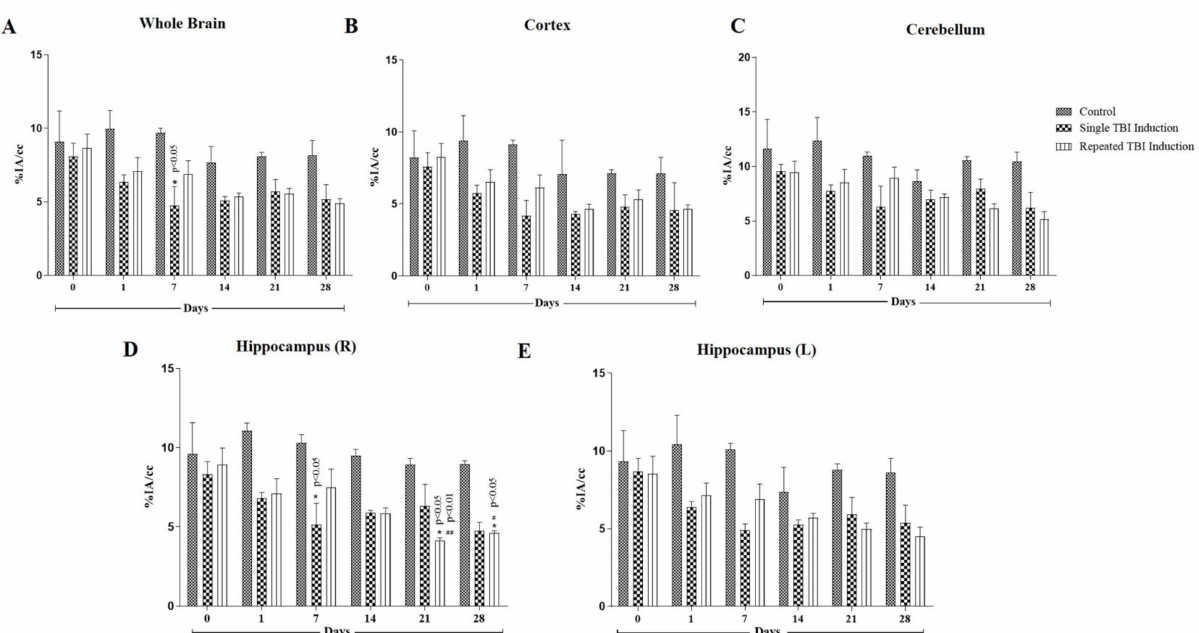
Figure 2. Quantification of glucose uptake in cortex, hippocampus and cerebellum regions of TBI mice brains following 18 F-FDG injection. Glucose uptake was expressed as % injected activity per gram (%IA/cc) in whole brain ( A ), cerebrum ( B ), cerebellum ( C ) and hippocampus ( D , E ). 8 F-FDG uptake was measured at days 0 (before TBI induction), 1, 7, 14, 21 and 28, after last induction. Values were expressed as mean ± SEM; n = 3, n = 3, and n = 4 for control, single and repeated TBI induction, respectively; mean difference between the groups were analyzed using two way ANOVA followed by Tukey’s multiple comparison test as post hoc using Graphpad prism software (v 8.0); * indicates p < 0.05 vs. control mice brains; #, ## indicate p < 0.05 and 0.01, respectively vs. glucose uptake by the respective day 0 mice